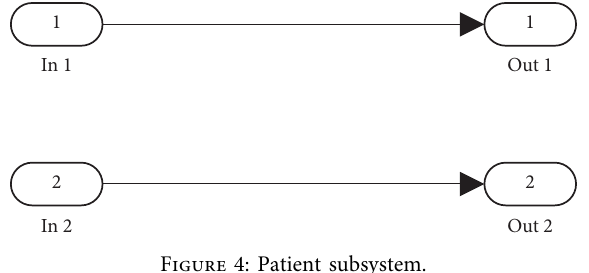
Figure 4: Patient